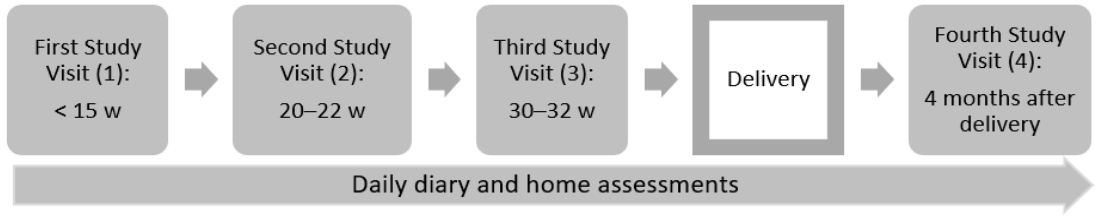
Figure 1. Schematic Timeline of B-WELL-MOM Study Visits.